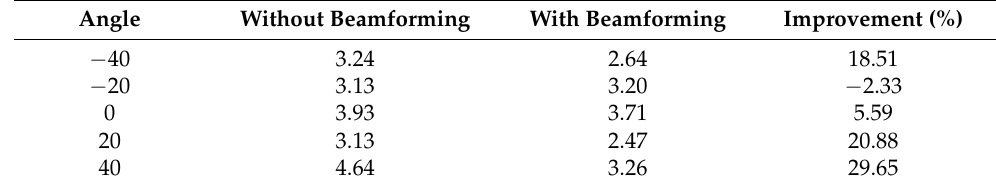
Table 7. The MAE of HR at 1.5